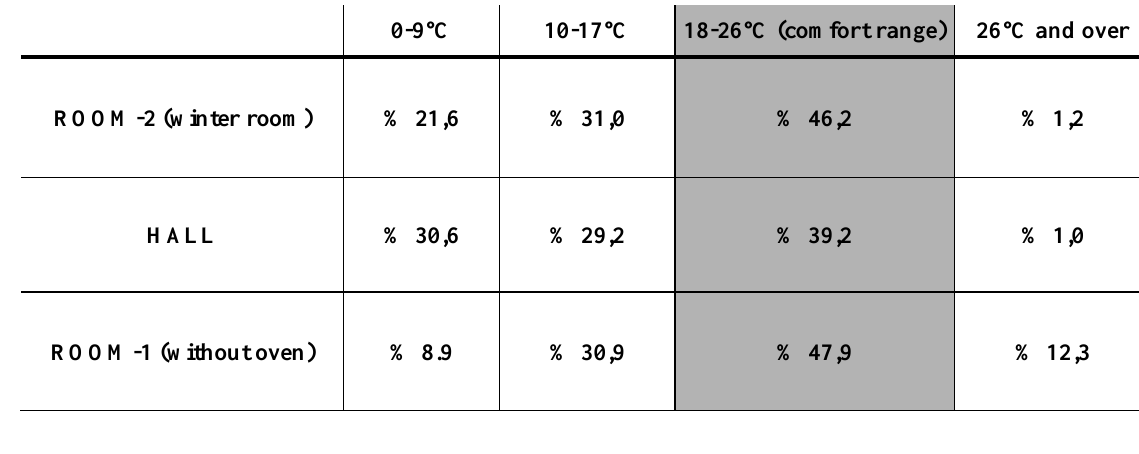
Table 1. Percentage of the annual temperature distribution for the three private space ("comfort range